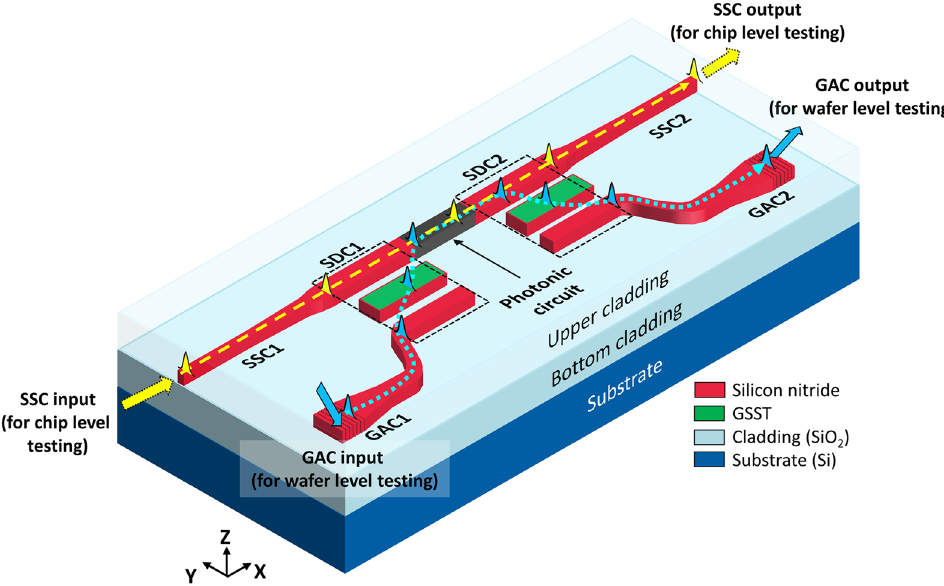
Figure 1. Illustration of the proposed RFWC module. Light fed from the input SSC1 propagates through the photonic circuit and exits through the output SSC2 (indicated by yellow line) when both SDC1 and SDC2 are deactivated. When they are activated, SDC1 and SDC2 couple the light into and out of the photonic circuit through the input and output GACs (marked by blue dotted